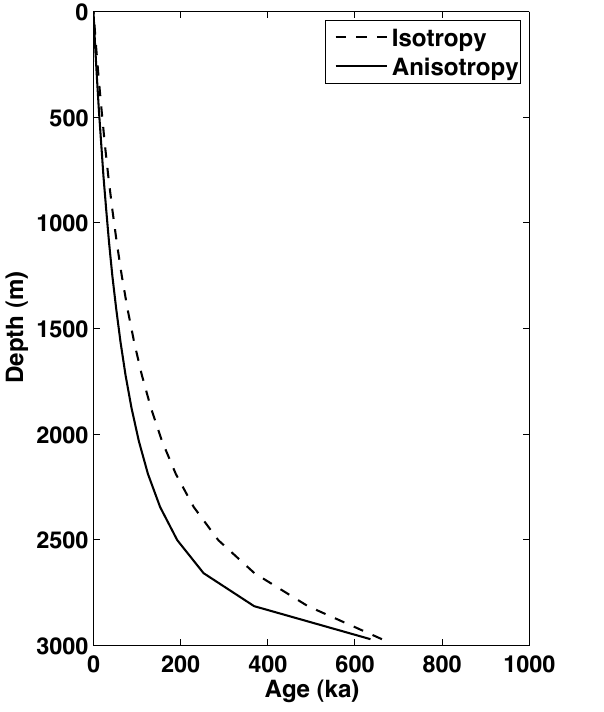
Fig. 15. Anisotropic and isotropic steady-state runs: age profiles at the Dome Fuji drill site.